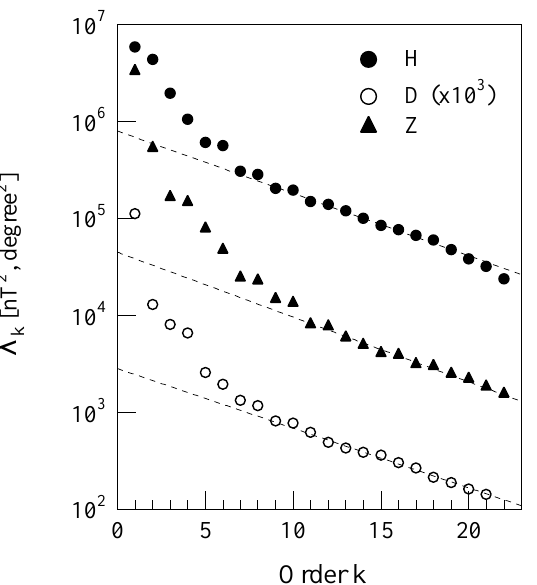
Fig. 3. The EOFs associated with the solar quiet daily variation for H, D and Z magnetic field elements. Fig. 4. The observed seasonal asymmetry is the same